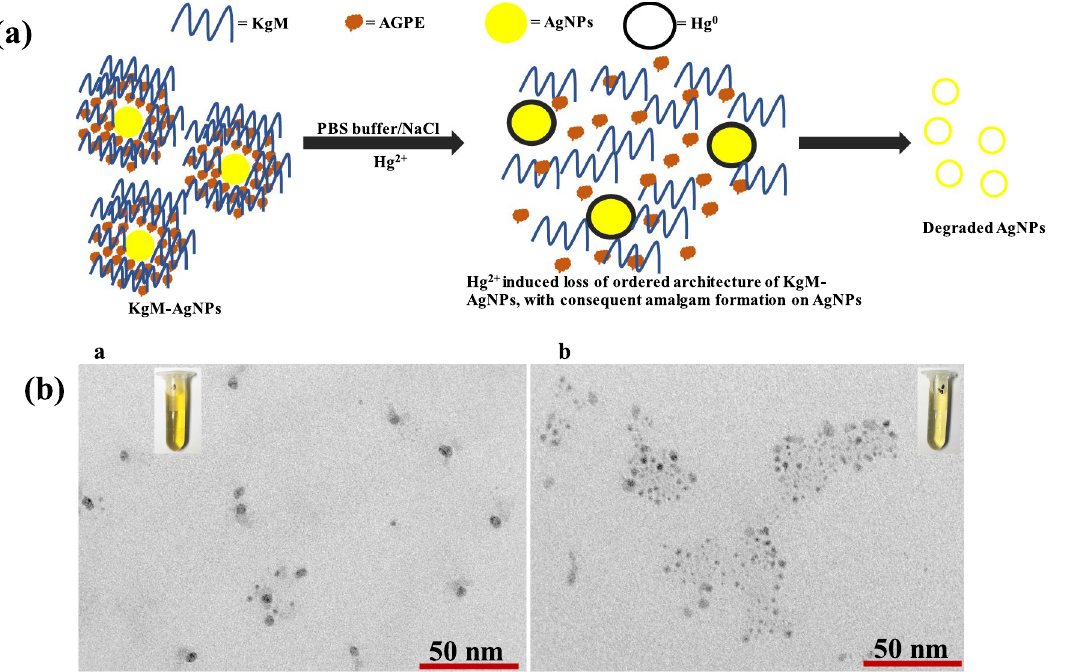
Figure 8. ( a ) Representation of the mechanistic basis of KgM-AgNPs towards the detection of Hg 2+ in aqueous solution ( b ) TEM images of KgM-AgNPs under Hg 2+ treatment at 0.00 and 30.0 µM, inset shows the photo images of the different